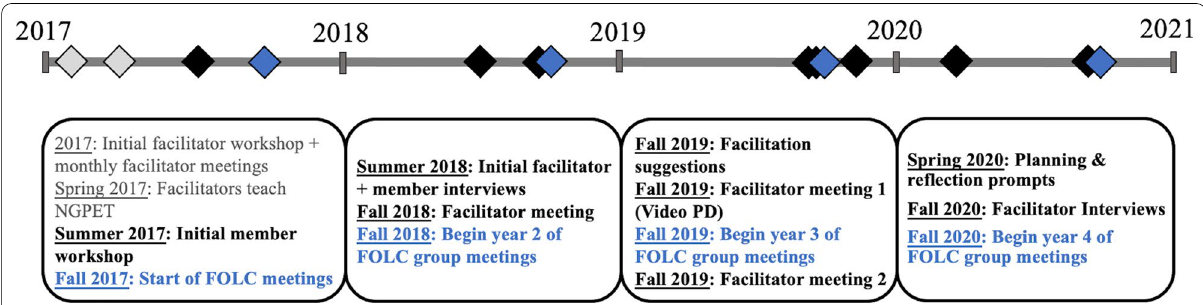
Fig. 2 Timeline of NGPET FOLC group member and facilitator activities. Note. The events in blue represent the successive years of the FOLC group meetings. The events in black represent facilitator and FOLC member activities (those in grey represent activities where the case facilitator was not